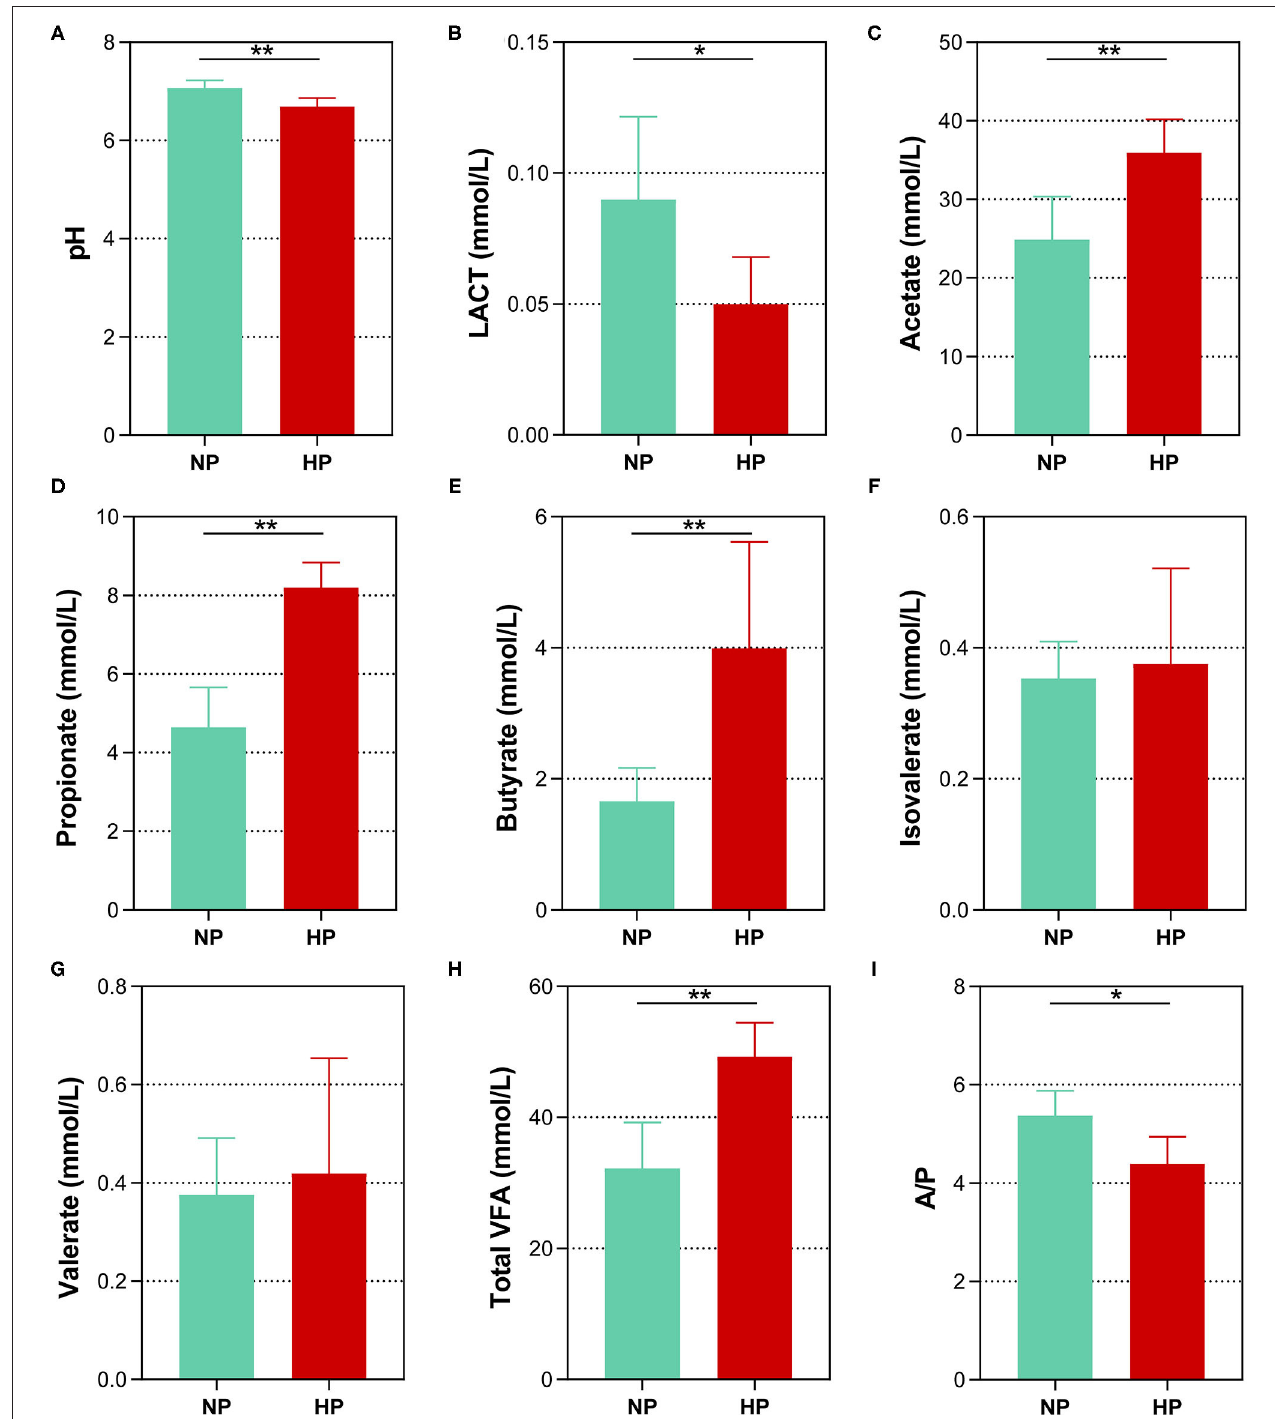
FIGURE 2 | Effects of normal and high paddy diets on hindgut (A) pH, (B) LACT and (C–H) SCFA concentrations in goats. (I) A/P, Acetate: Propionate. *0.01 < p < 0.05; ** p < 0.01.